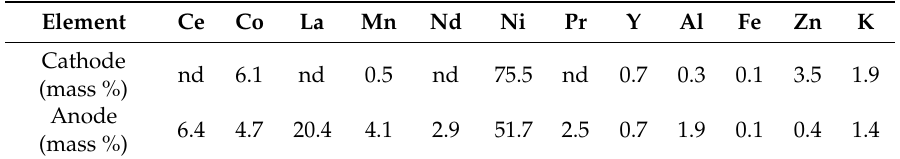
Table 6. Chemical composition of cathode and anode materials in mass percentage (nd- not detected). Element Ce Co La Mn Nd Ni Pr Y Al Fe Zn K Cathode nd 6.1 nd 0.5 nd 75.5 nd 0.7 0.3 0.1 3.5 1.9 (mass %) Anode 6.4 4.7 20.4 4.1 2.9 51.7 2.5 0.7 1.9 0.1 0.4 (mass %)